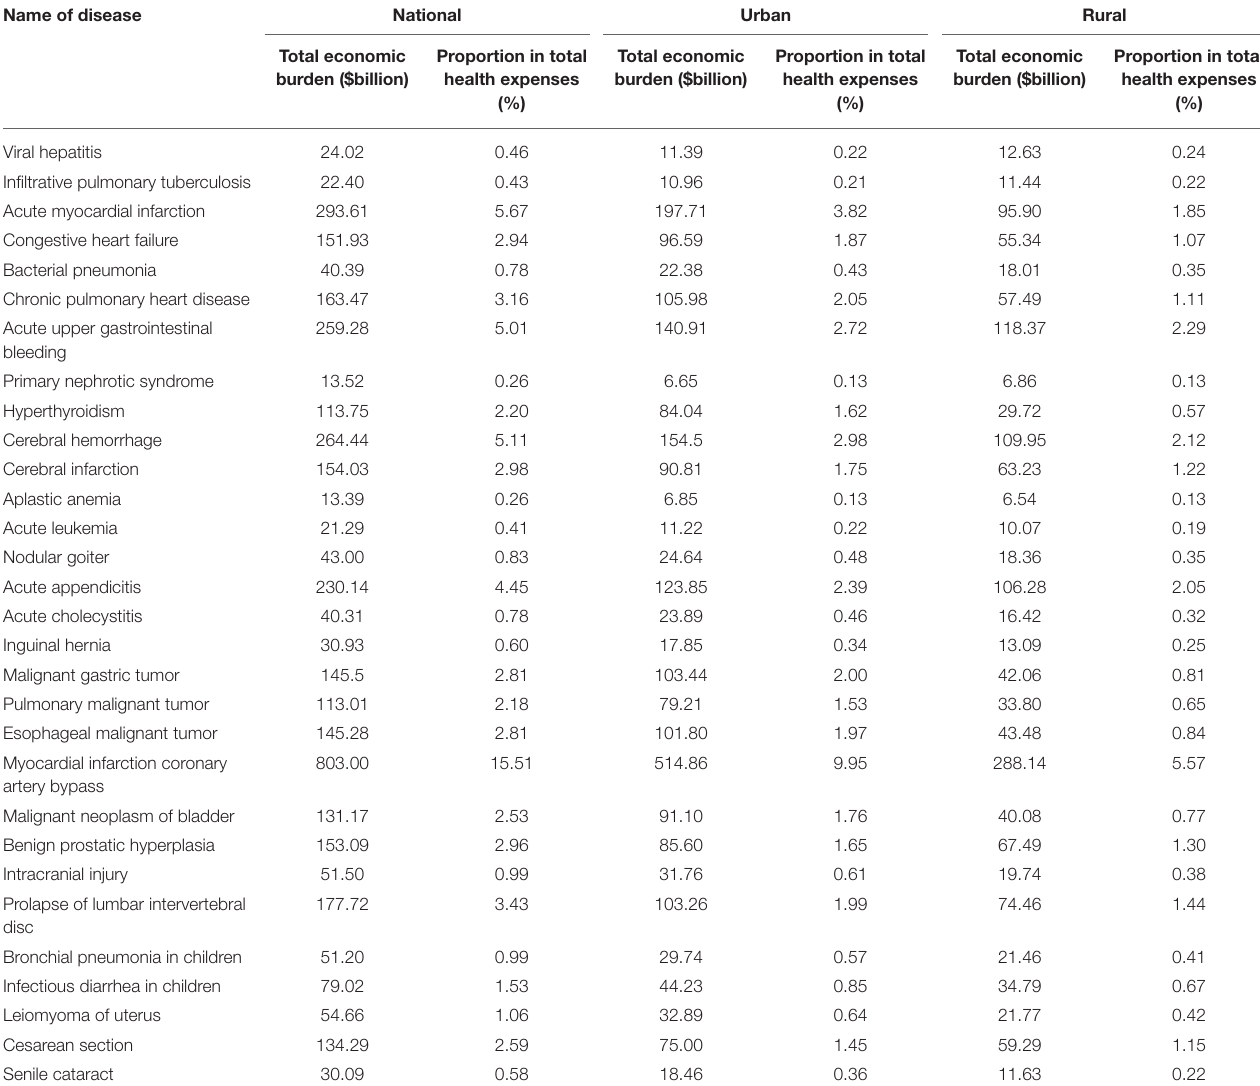
TABLE 5 | Total economic burden of 30 types of diseases in China in 2013. Name of